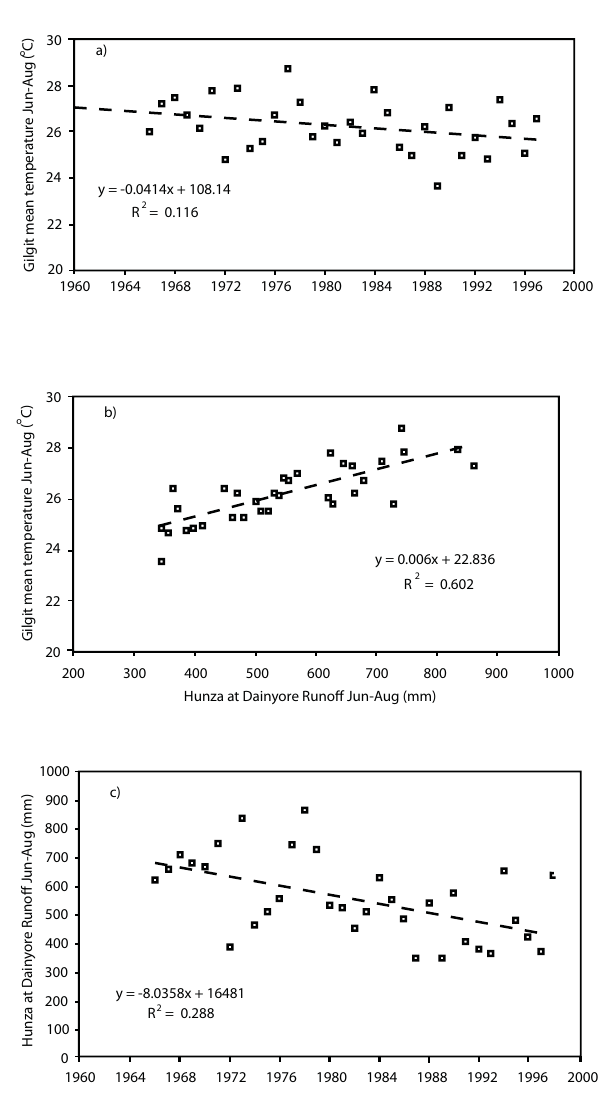
Fig. 4 Relationship between temperature at Gilgit and runoff at the River Hunza at Dainyor Bridge (a) Temperature trend from June to August; (b) Relationship between seasonal temperature and runoff (mm) from June to August; (c) Runoff trend from June to August (after Fowler and Archer, 2006).